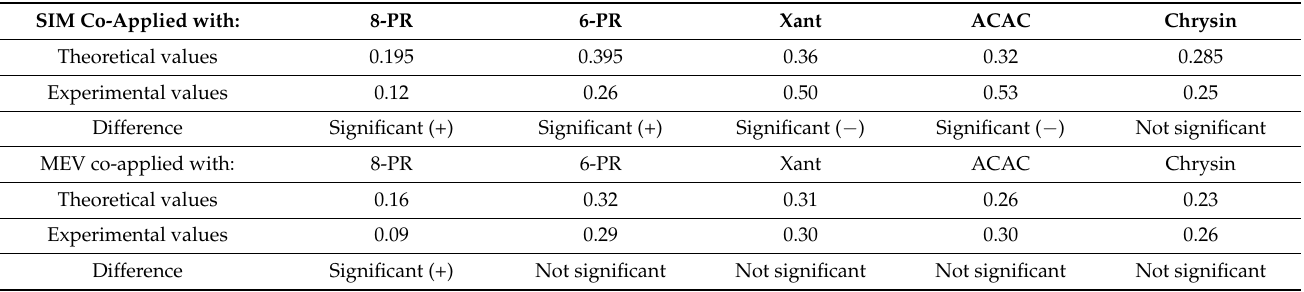
Table 1. Theoretical and experimental values of the relative peak currents upon co-application of